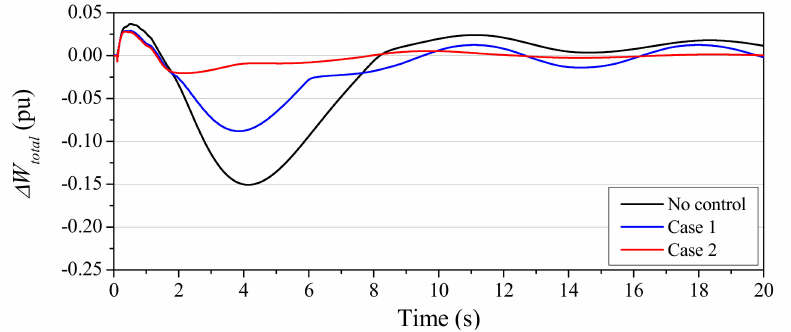
Figure 9. ∆ W total : deviation of summation of kinetic energy of each SG (with SG3 installed).